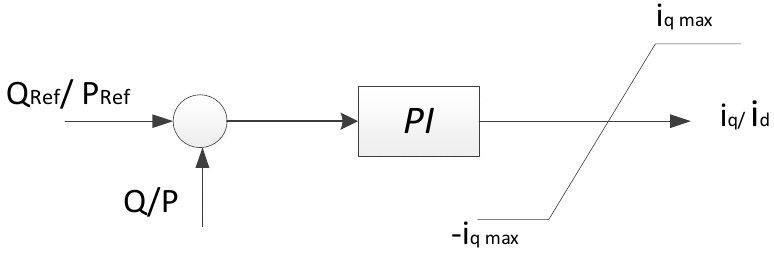
Figure 9. The dq frame reactive and active power controller.